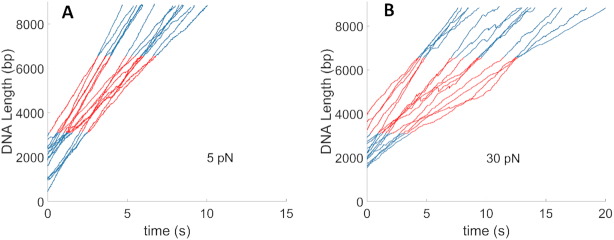
Measurements of length of DNA translocated versus time with the linear plasmid DNA sequence. Parts of the dataset containing the non-A-philic flanking plasmid sequences (sections I and III) are indicated in blue (see online figure) and parts containing the synthetic A-philic, high % GC sequence (section II) are indicated in red (see online figure). (A) Measurements with 5 pN applied force (examples from N = 134 recorded events) (B) Measurements with 30 pN applied force (examples from N = 45 recorded events).